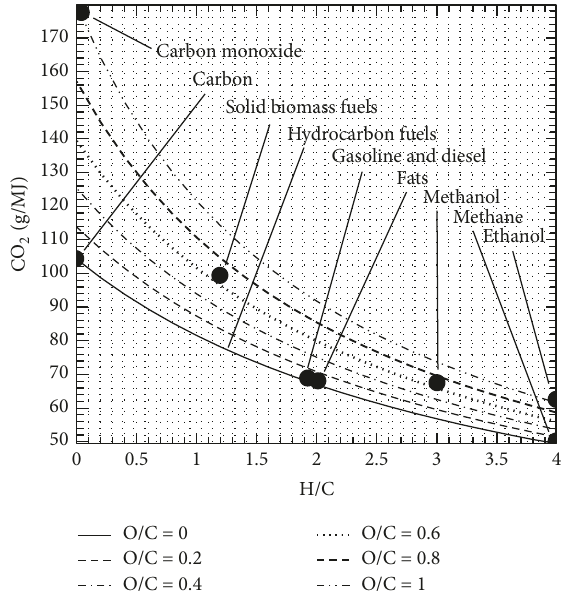
Figure 5: Effect of H/C and O/C on the CO 2 emission from fuels. Fuels with higher RQ factor emit higher amounts of carbon dioxide.